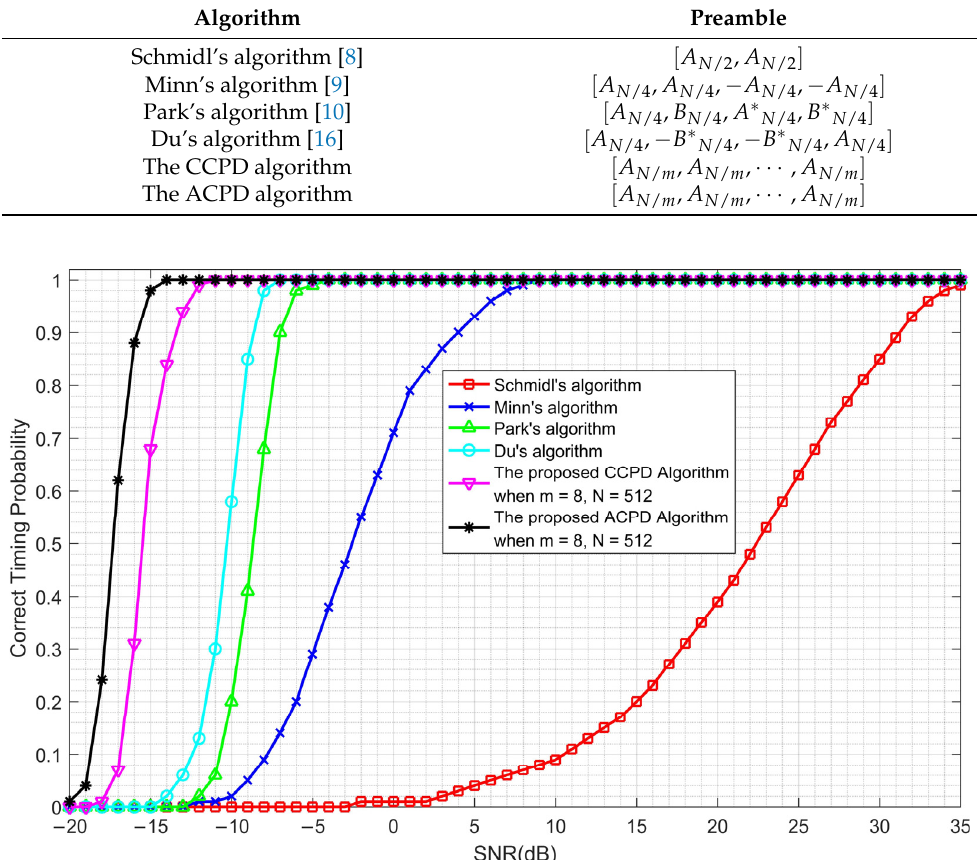
Figure 14. Correct timing probability comparison of the proposed algorithms with previous algo- rithms.